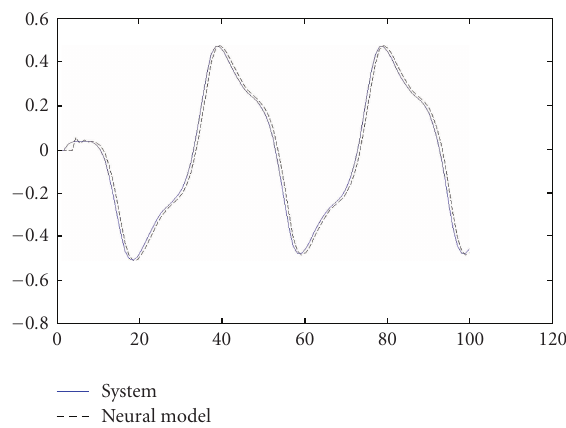
Figure 2: Evolution of the system output and the neural model output ( ε ∈ stability domain).